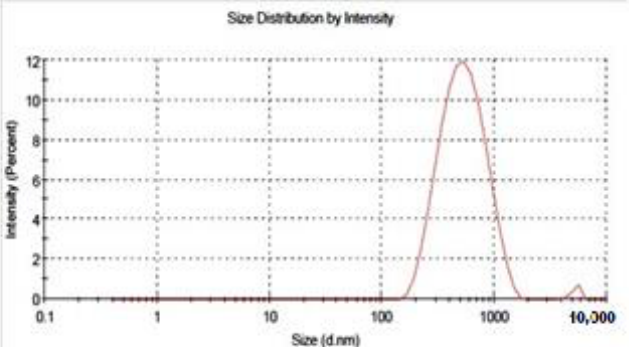
Figure 2. Droplet size distribution and polydispersity index (PDI) of WCSNPs.